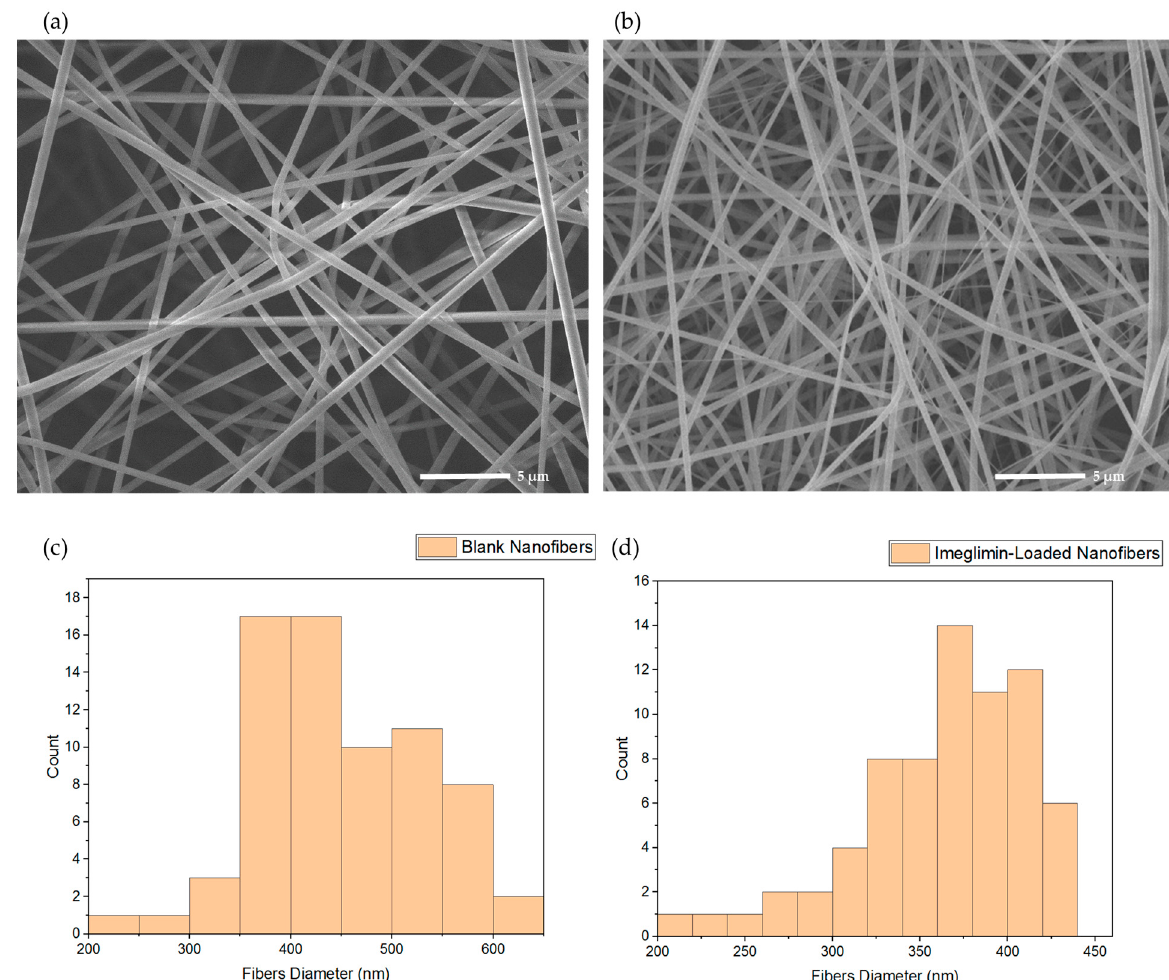
Figure 1. SEM images that show ( a ) blank nano fi bers and ( b ) imeglimin-loaded nano fi bers as smooth, non-porous, and non-beaded, with average fi bers diameters of 450 ± 82 nm and 361 ± 54 nm, respectively (n = 70). The diameter distribution of ( c ) blank nano fi bers and ( d ) imeglimin-loaded nano fi bers show the average diameters of the fi brous systems.